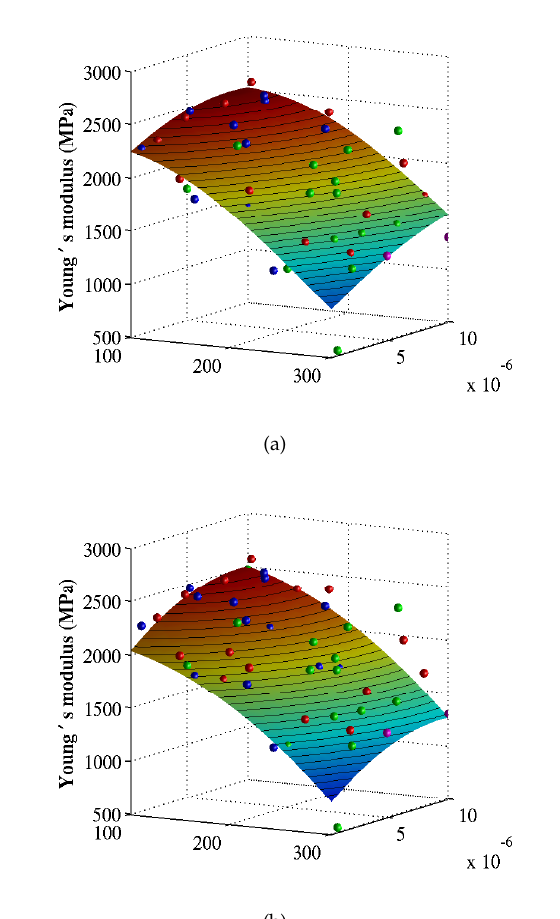
Figure 8. Surrogate models for the Young’s modulus corresponding to ( a ) Kriging regression and ( b ) Bayesian updating. The training data are obtained from MD